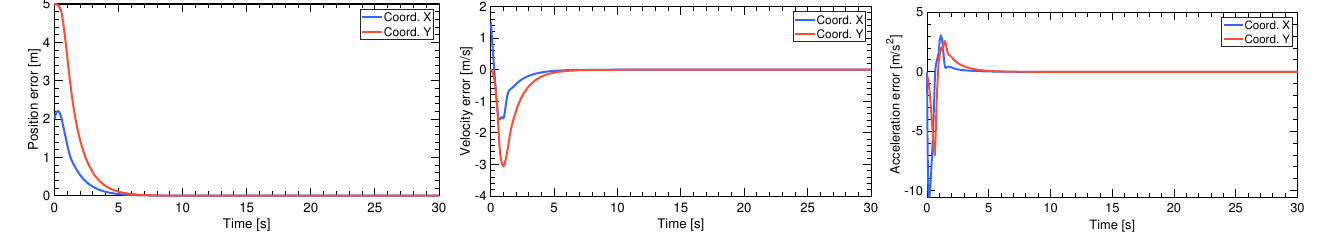
Figure 11. Trajectory following test: position ( left ), velocity ( middle ), acceleration ( right ) errors.